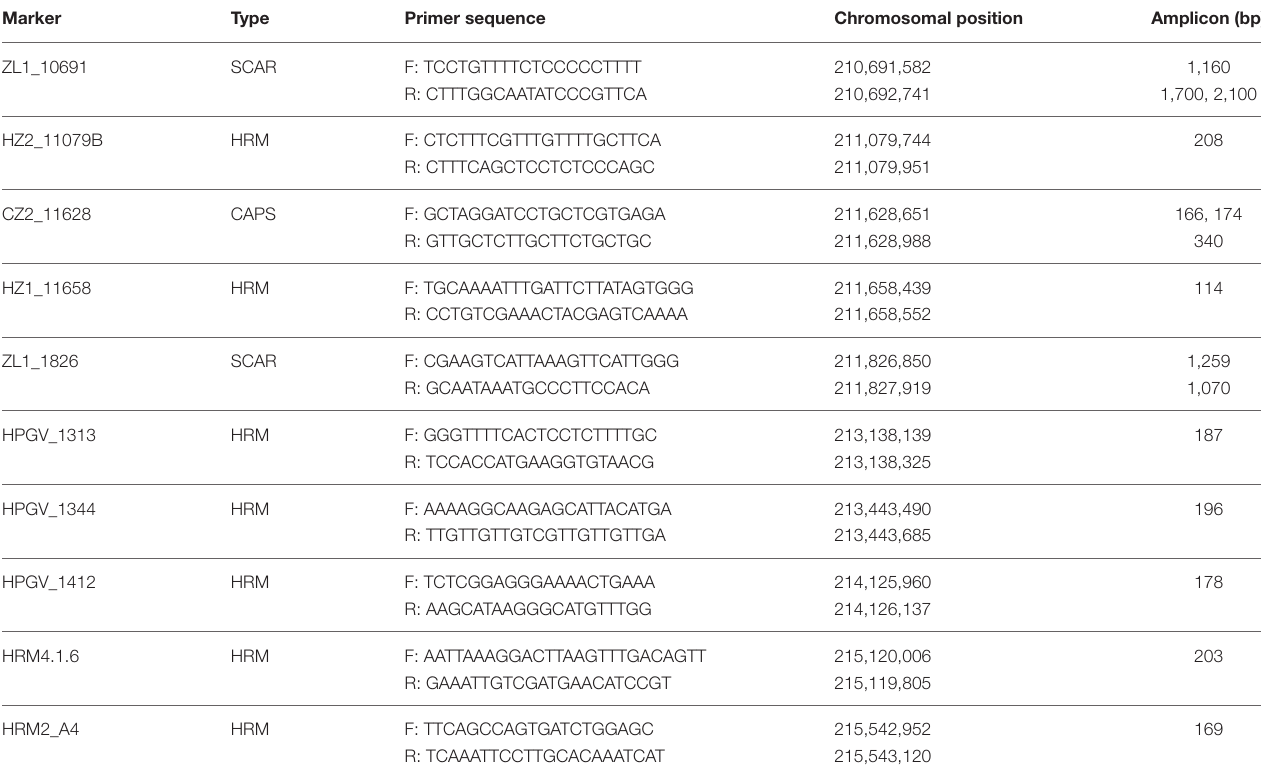
TABLE 1 | Molecular markers linked to the powdery resistance gene PMR1 .